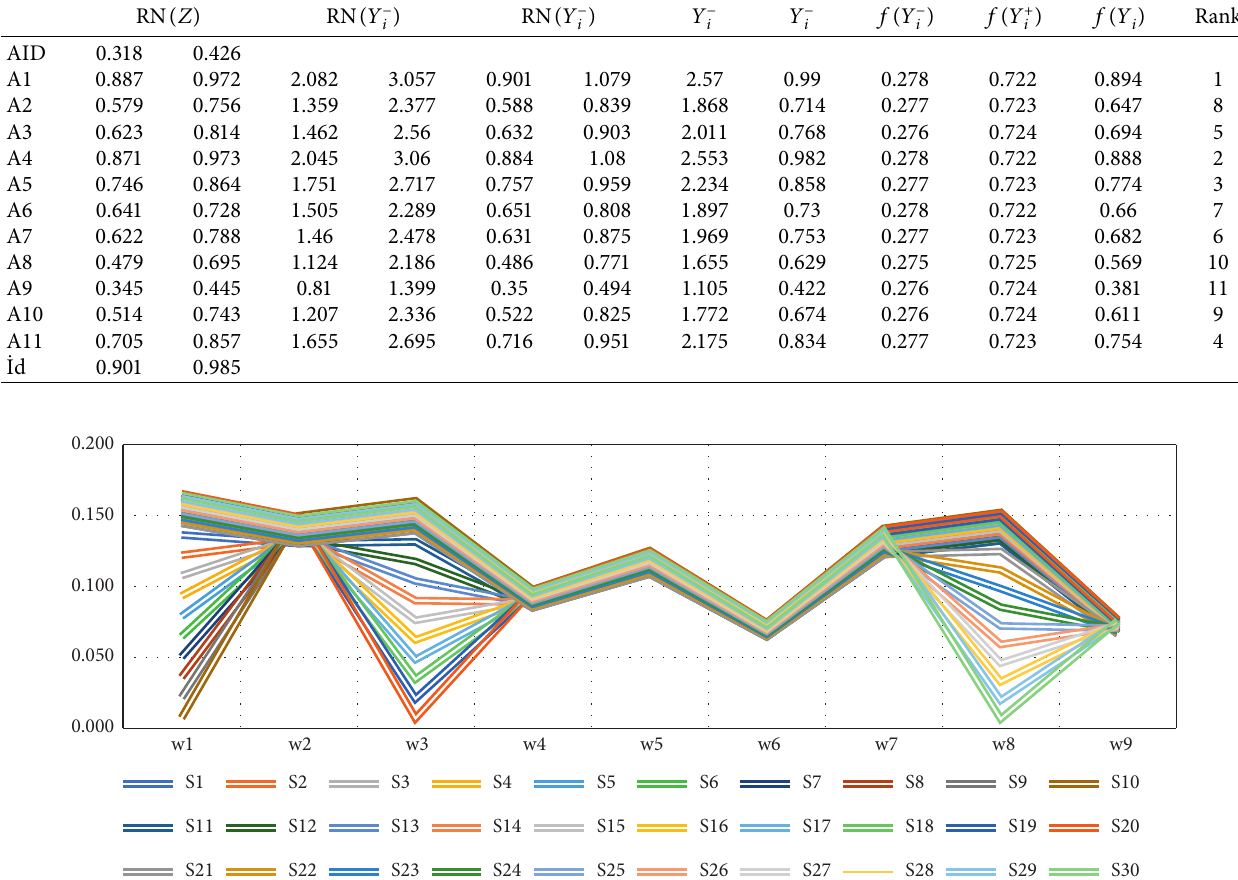
Table 13: The results of Rough MARCOS.